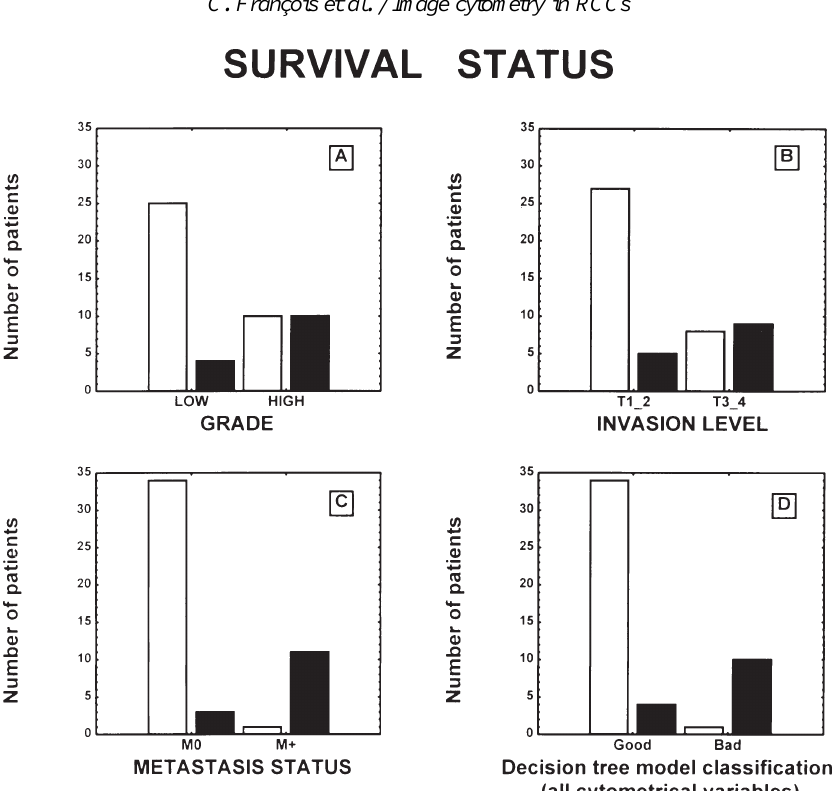
Fig. 2. This figure shows the breakdown of the patients in terms of good (white column) and bad (black column) survival status in function of tumour grade (A) and invasion level (B), and the presence or absence of metastases (C). Figure (D) shows the classification results obtained by means of the decision tree model performed on cytometry-generated